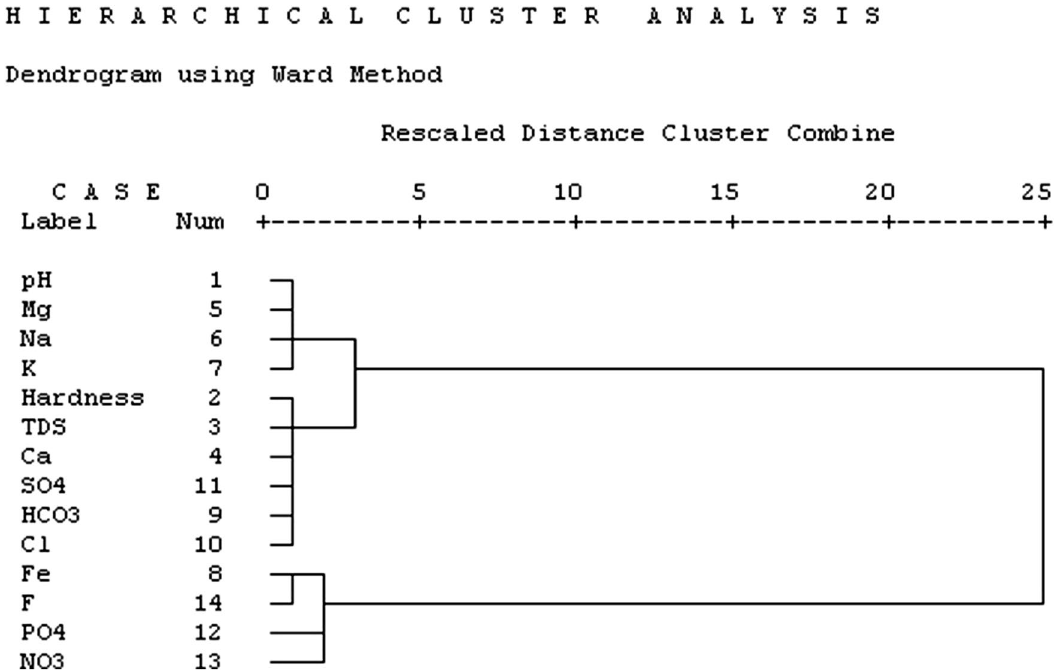
Fig. 8 Dendrogram of hierarchical cluster analysis of the selected aquifers in the dry